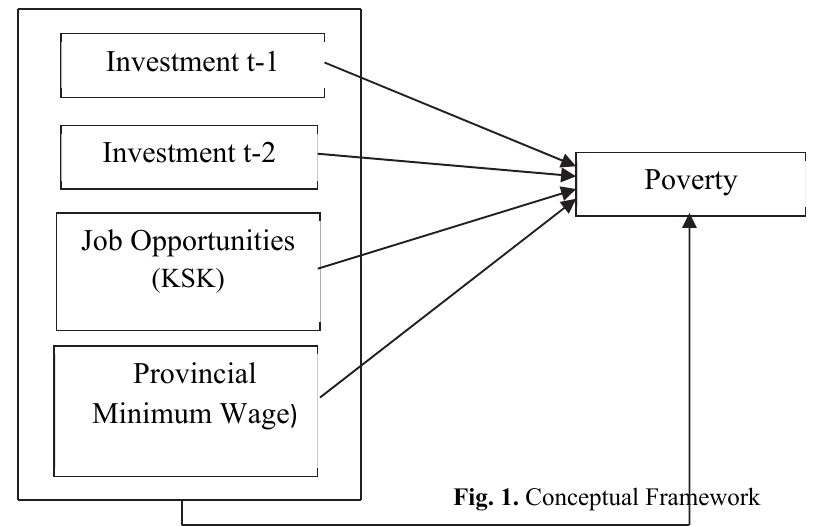
Fig. 1. Conceptual